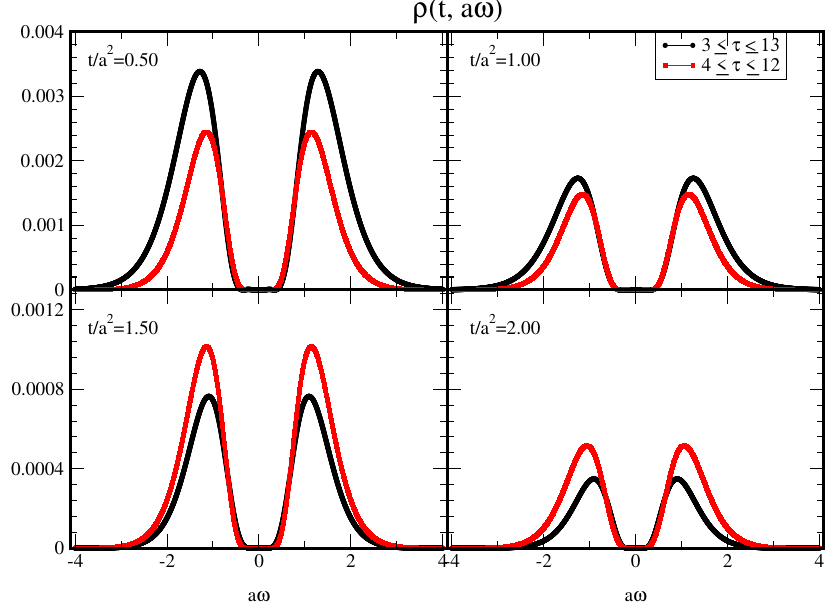
Figure 9 . The (cid:28) -regime dependence of the spectral function for several (cid:13)ow-time